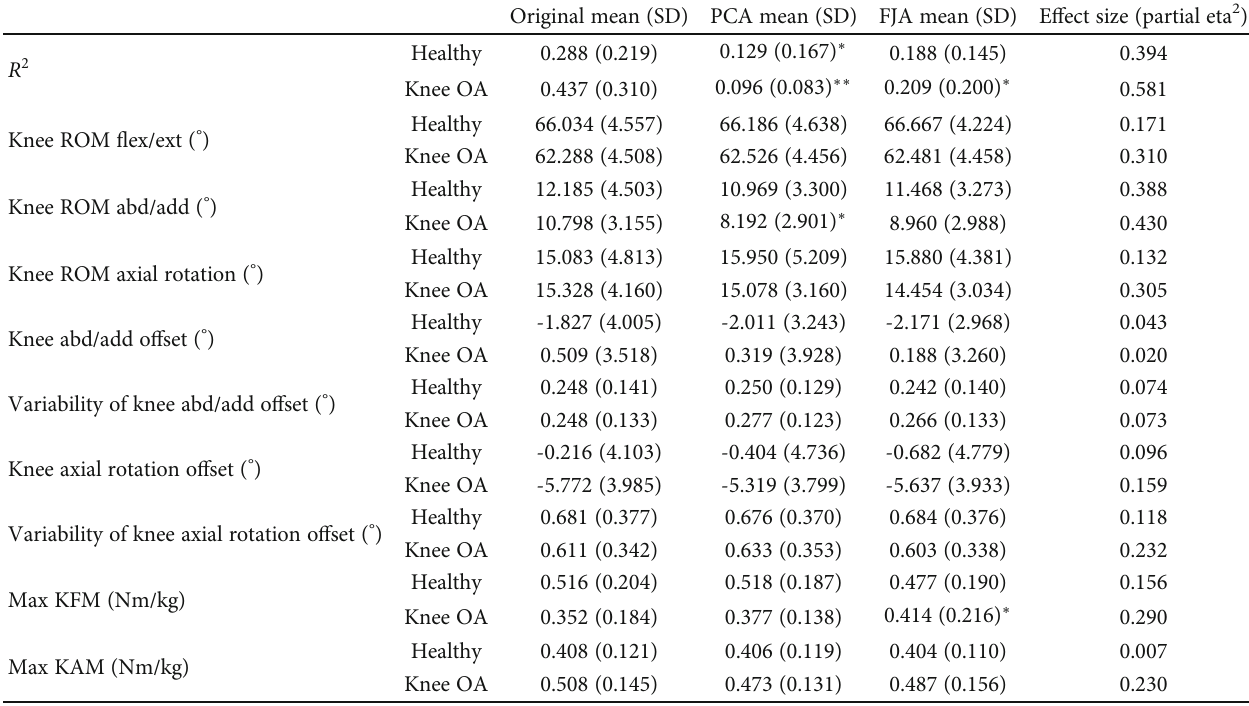
Table 1: Descriptive statistics for the key kinetic and kinematic